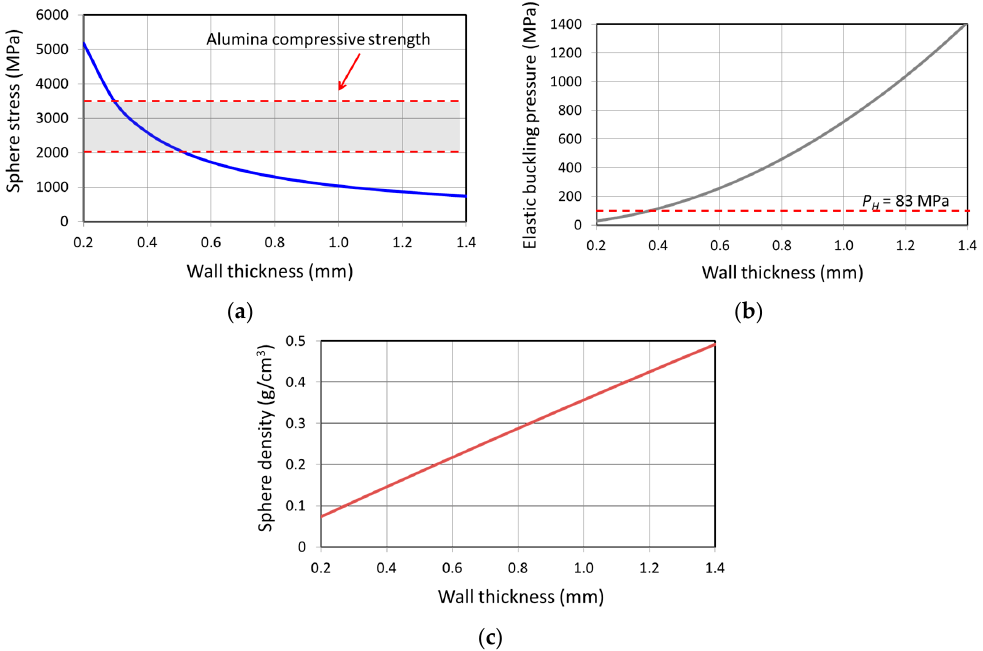
Figure 3. ( a ) calculated sphere stress at 83 MPa of hydraulic pressure; ( b ) elastic buckling pressure of the sphere walls and ( c ) sphere density for the alumina-based ceramic spheres made of alumina materials with various wall thicknesses.